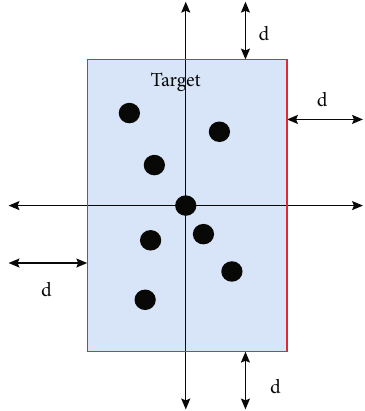
Figure 6: Multihuman target dynamic search